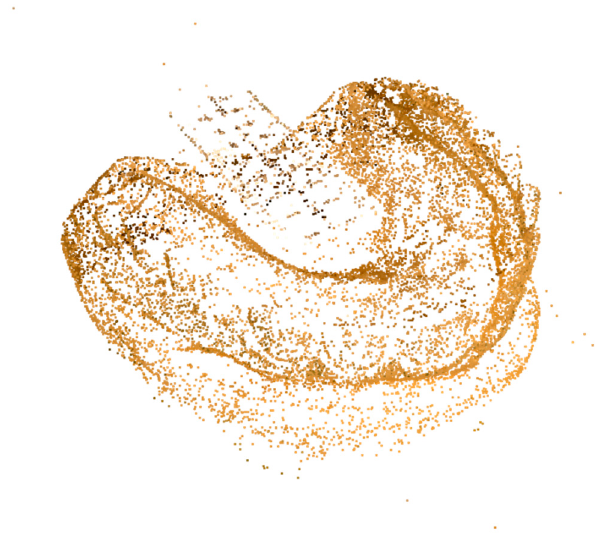
Figure 2. Sparse point